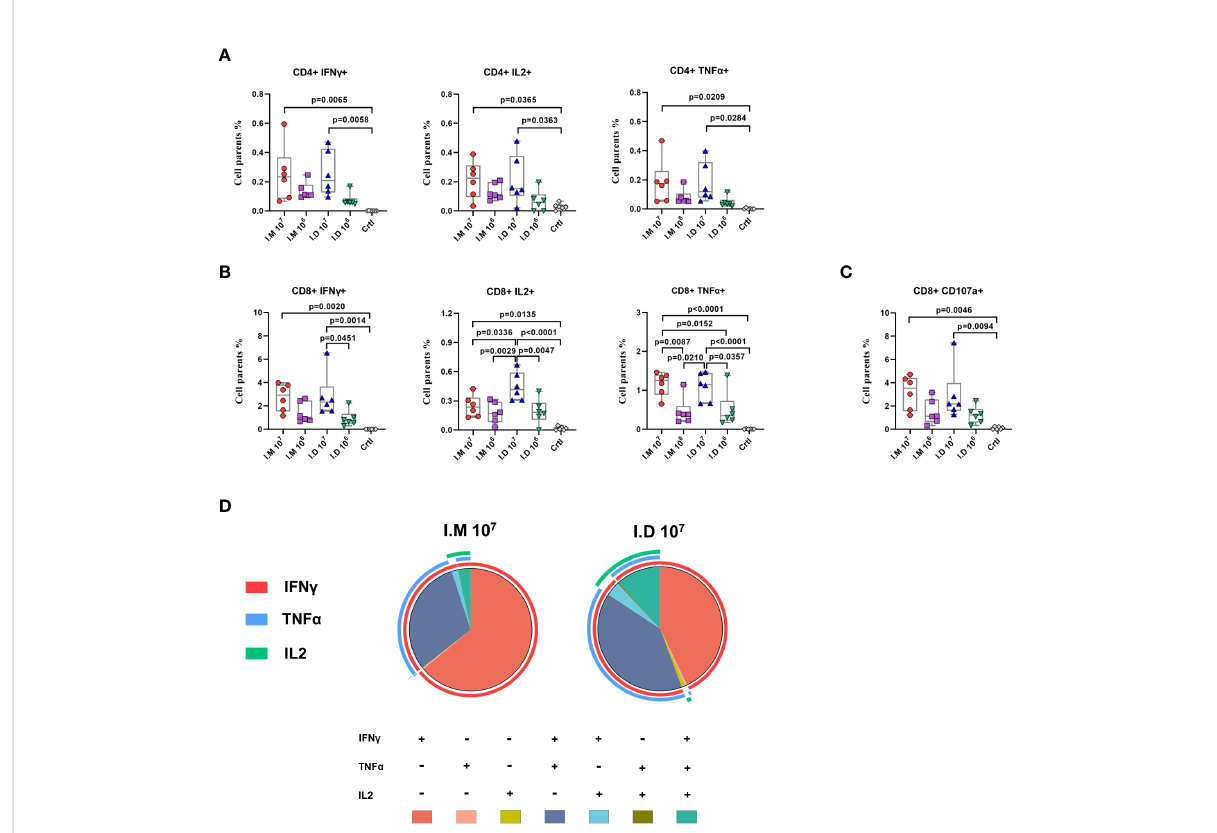
FIGURE 2 Intradermal injection stimulates a richer multifunctional cellular immune response than intramuscular injection. (A – C) Glycoprotein-speci fi c cytokines (IFN g , IL-2, TNF a ) producing CD4+ T cells (A) , CD8+ T cells (B) and CD107 producing CD8+ T cells (C) was measured and analyzed by a fl ow cytometry. (D) Proportions of glycoprotein-speci fi c CD8+ T cells that produce any combination of the three cytokines at day14. Data is represented as median with 95% CI. Statistical signi fi cance was determined using one-way ANOVA followed by Tukey ’ s multiple comparisons